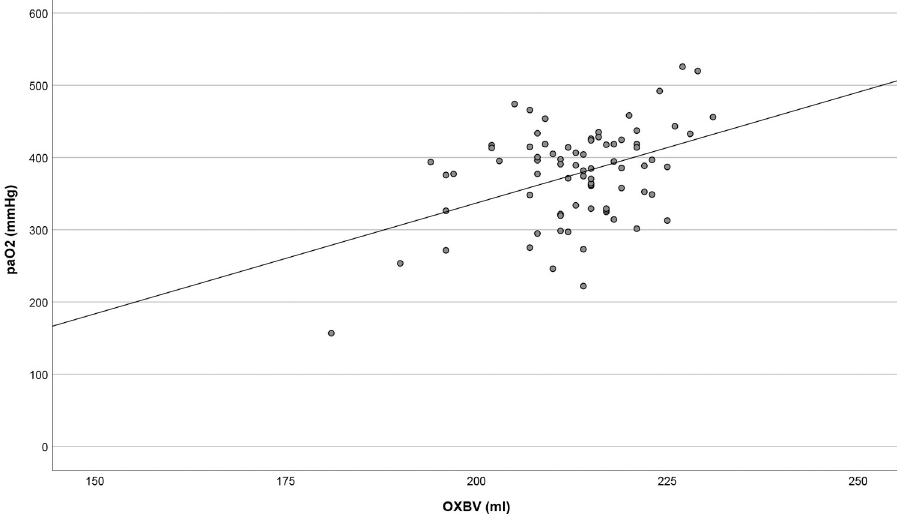
Fig 2. Average OXBV vs. post-oxygenator pO 2 . Represented is all data with a minimum blood flow rate of 3 L/min, a minimum sweep gas flow of 2 L/min and a fiO 2 of 100%. paO 2 = post-oxygenator pO 2 , OXBV = oxygenator blood